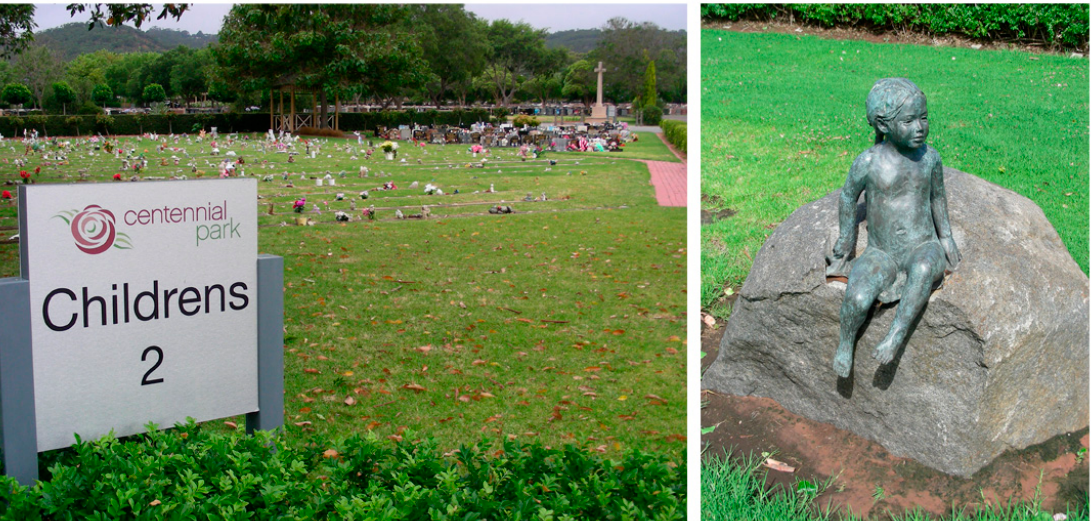
Figure 2. Demarcations of children’s cemetery spaces: ( left ) The children’s section in Centennial Park Cemetery, Adelaide; ( right ) symbolic figure situated adjacent to the children’s section in Enfield Memorial Park, Adelaide. Photographs: S. Muller 2016.